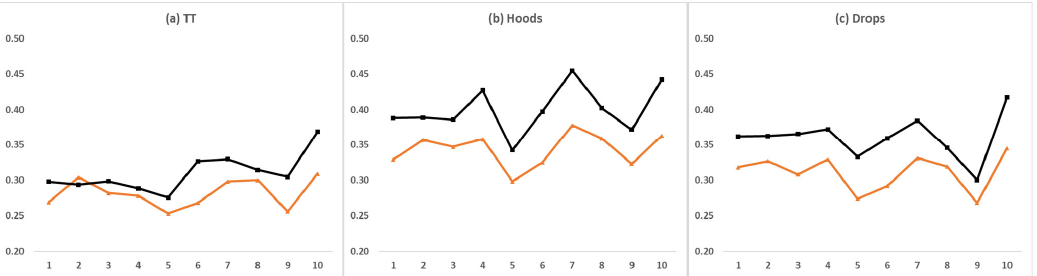
Figure 8. Area obtained from the projected frontal area camera (orange) and 3D models (black) are compared in this figure for ( a ) TT , ( b ) Hoods , and ( c ) Drops . The area is plotted on the y-axis, with units m 2 against the participant numbers on thee x-axis.